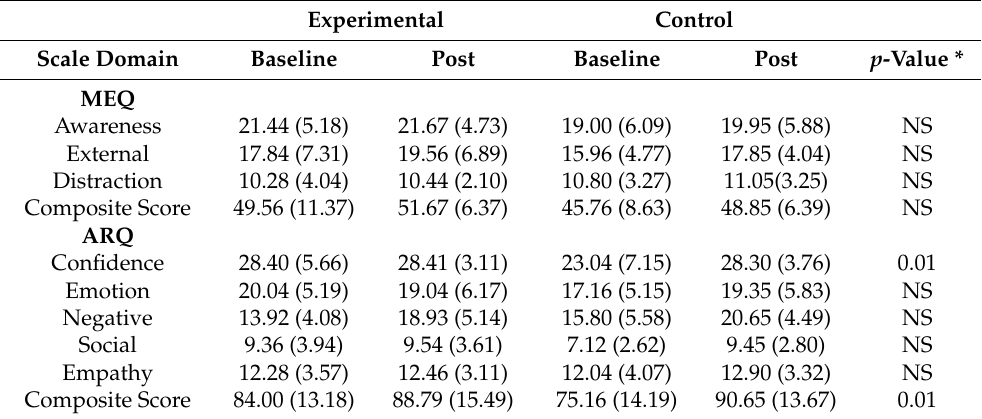
Table 4. Mean (SD) Baseline and post-intervention values of psychosocial measures in the E and C